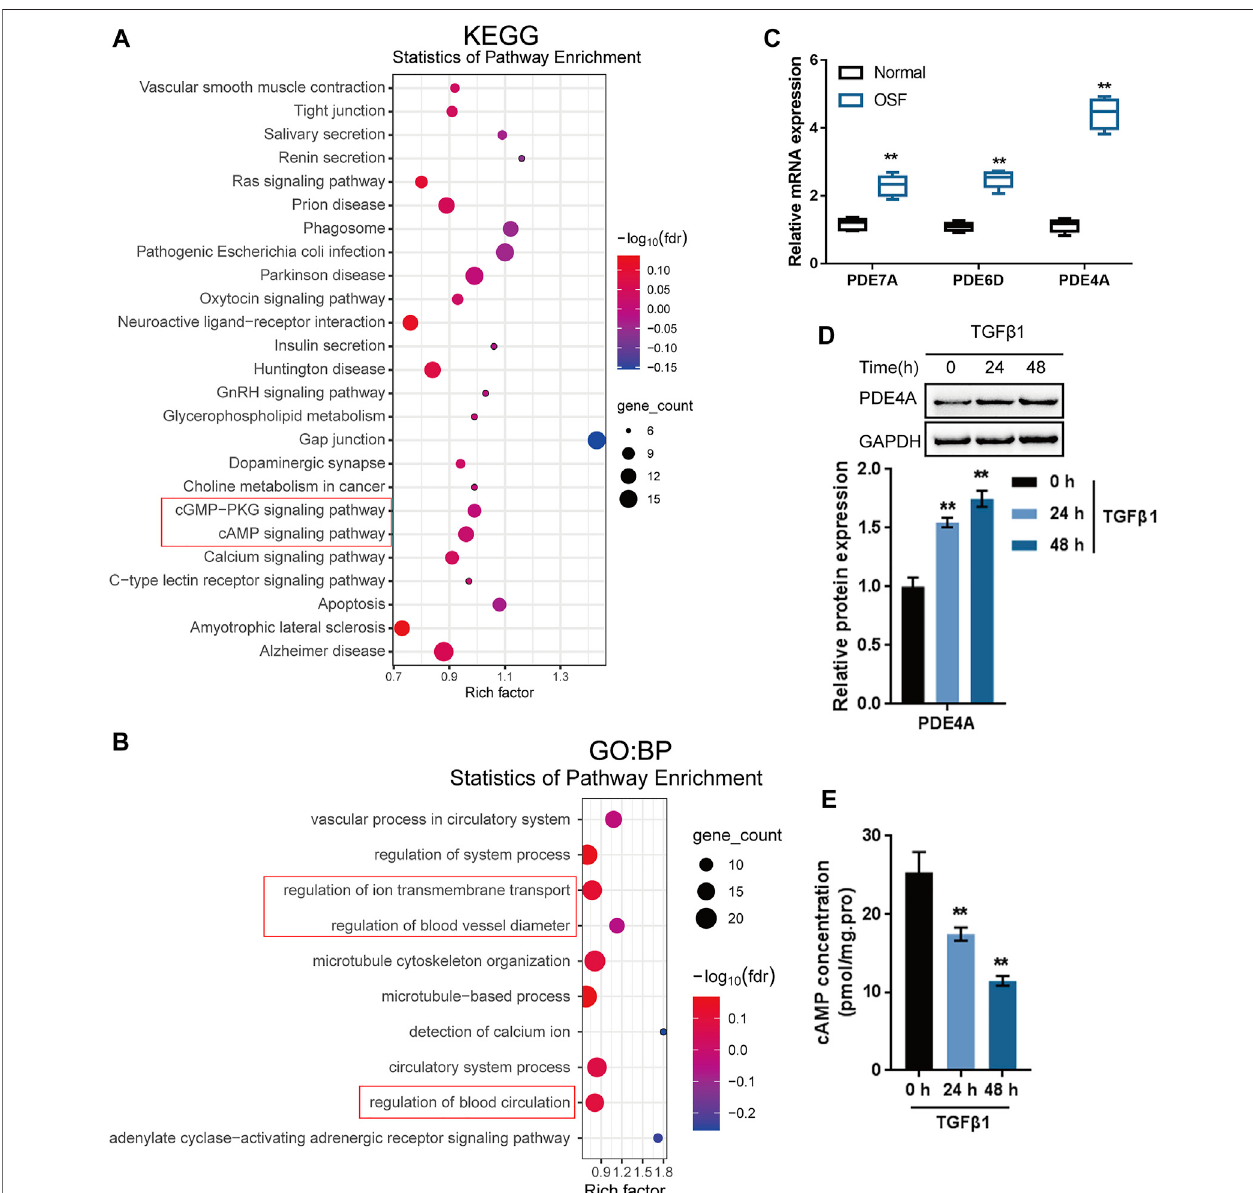
FIGURE 2 | Identi fi cation of proteins interacting with arecoline by bioinformatics and experimental analyses. (A,B) KEGG signaling pathway annotation and GO targetgenesfunctionsigni fi canceanalyseswereperformedoncandidateproteinsthatmightinteractwitharecoline. (C) ThemRNAlevelsofPDE4A,PDE6DandPDE7A in collected normal oral mucosal and OSF tissues. (D) BMFs were treated with 5 ng/ml TGF- β 1 for 0, 24, and 48 h and examined for the protein levels of PDE4A by Immunoblotting, n (cid:1) 3. (E) cAMP concentration was determined by a direct cAMP ELISA kit. n (cid:1) 3, ** p < 0.01 compared with the normal or control group. ANOVA followed by Tukey post-hoc